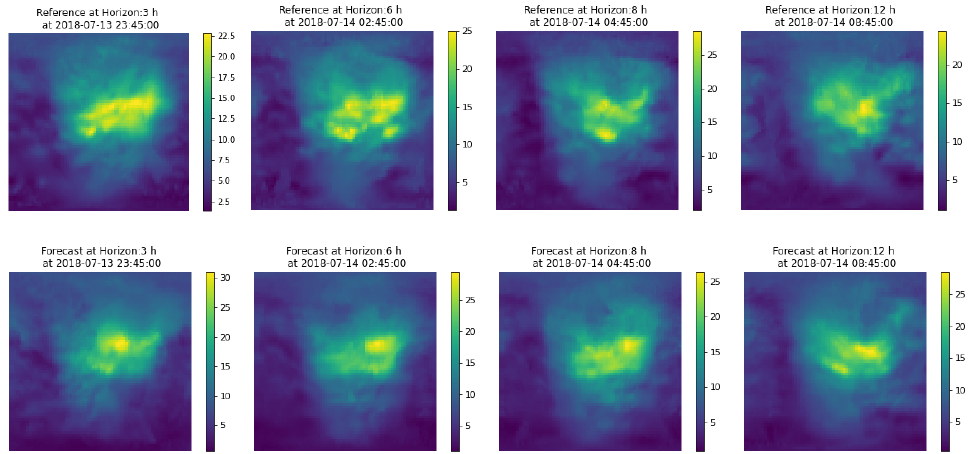
Figure 3. Nearest maps are distributed along solar cycles C24 and C25 . Histograms of the years ( left ), months ( center ) and time of day ( right ) of the nearest maps to the map at 2019-05-21 16:15:00 UTC .